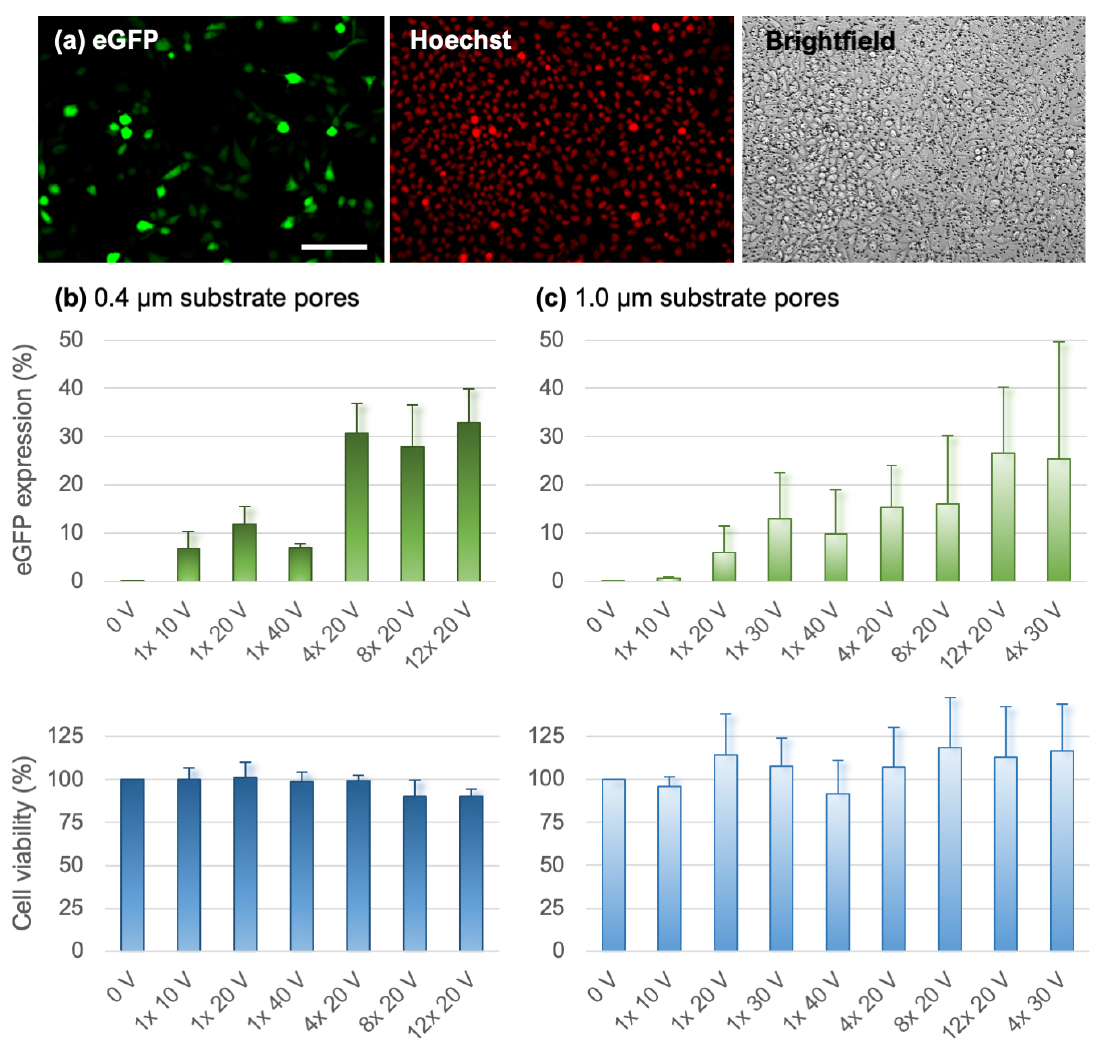
Figure 5. Transfection efficiency and cell survival in CHO cells. ( a ) Representative fluorescence image showing cells expressing eGFP ( left ), all cell nuclei stained with Hoechst 33342 ( middle ), and the corresponding brightfield image ( right ). Scalebar 100 µ m. ( b ) Results obtained using substrates with 0.4 µ m pores. Samples were exposed to 10 ms pulses of indicated number and amplitude. eGFP expression was determined as the percentage of fluorescent cells using flow cytometry. Cell viability was determined by the metabolic MTS assay. Graphs show mean ± s.d. from 3 − 4 experiments. ( c ) Results obtained using substrates with 1.0 µm pores in the same way as in ( b ).